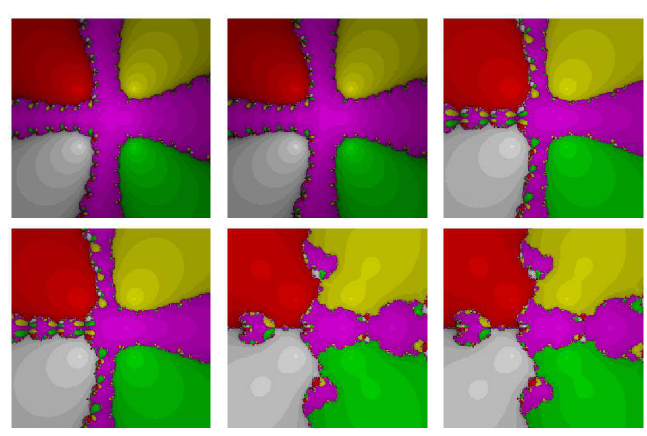
Figure 1. The basins of attraction for RM 2 , MRM 2 , HM 3 , MHM 3 , SM 3 and MSM 3 , from left to right and top to bottom, respectively in Problem 1.